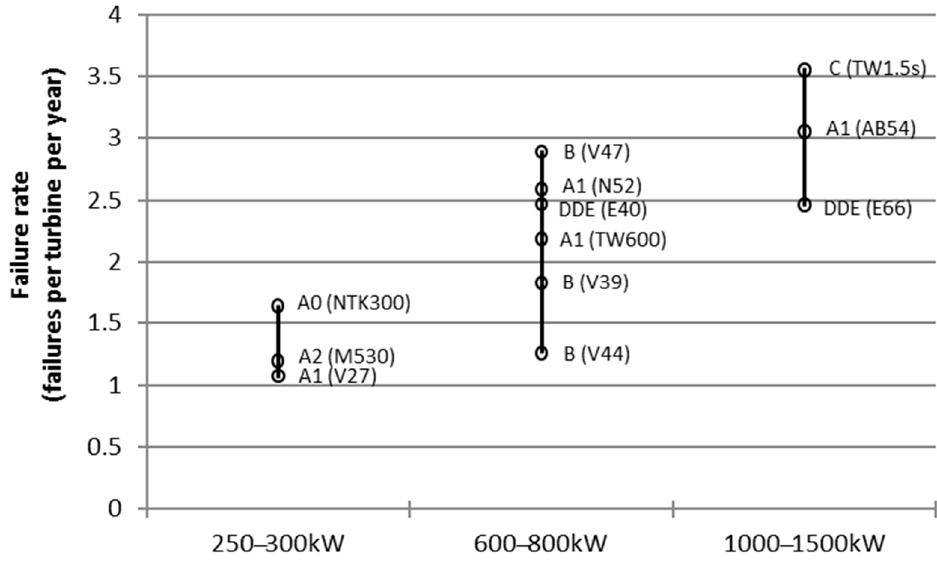
Figure 1. Distribution of failure frequencies between different turbine types, sorted by turbine size (Adapted from [5] ) .